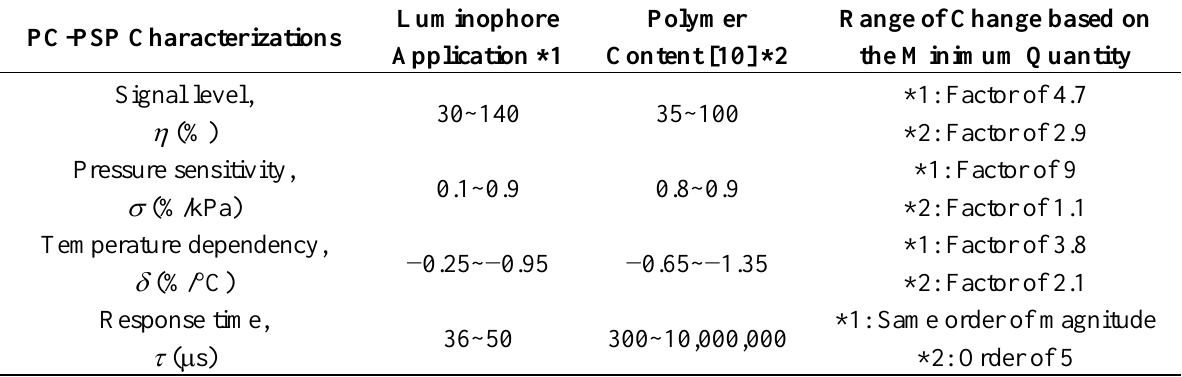
Table 1. Summary of PC-PSP characterizations as well as the comparisons from the previous study that discussed the polymer content